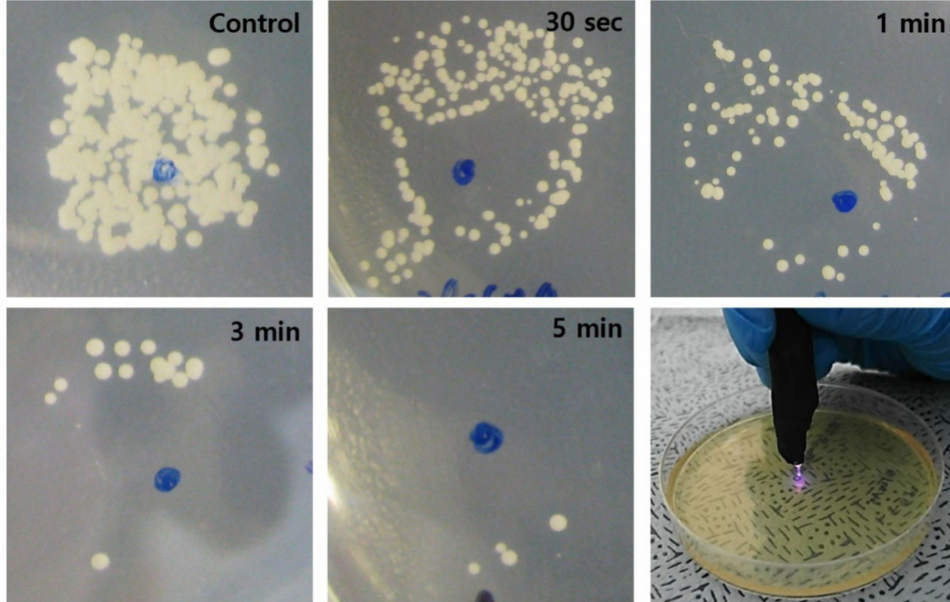
Figure 4. Photographs showing the time-dependent fungicidal ( C. albicans ) effect of the plasma jet. As the plasma treatment time increased, the area of complete sterilization (area without fungus) increased accordingly. Scale bars = 5